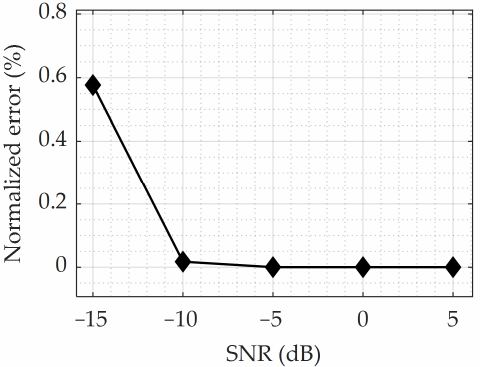
Figure 9. The variation of rotational frequency estimation error with the SNR.